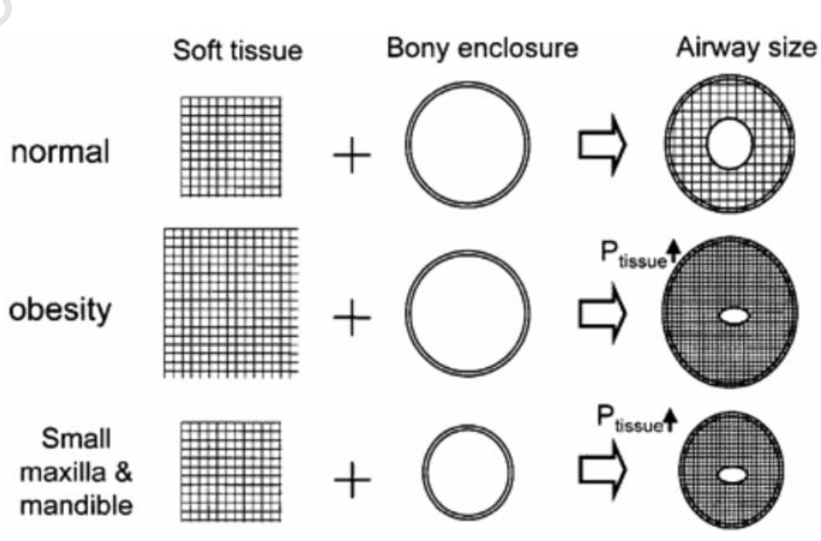
Figure 1. Reprinted with permission of the American Thoracic Society. Copyright (c) 2011 American Thoracic Society. White D. Pathogenesis of obstructive and central sleep